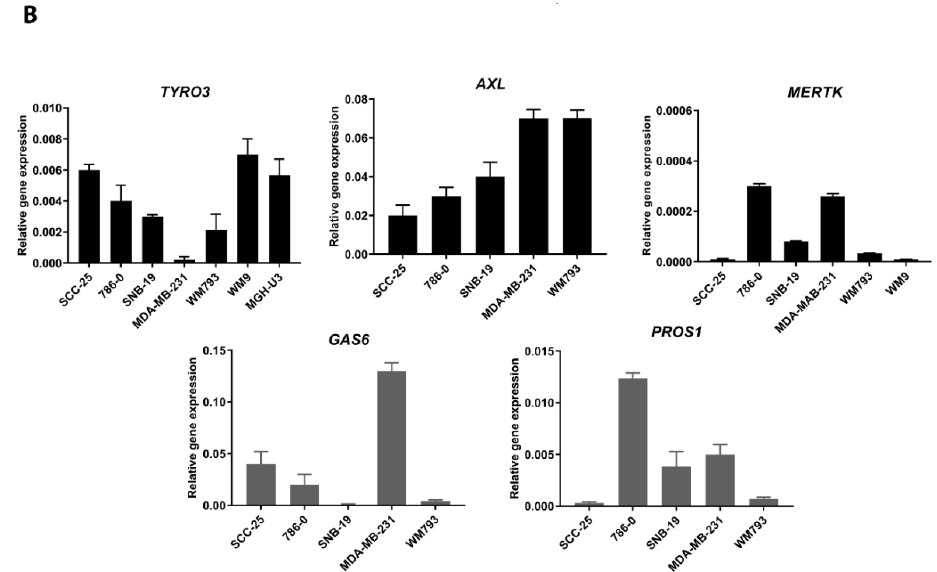
Figure 1. Expression of TAM RTKs and their ligands in a panel of human cancer cell lines (details in Supplementary Table S1). ( A ) Representative Western blot image from analysis of TAM receptors in protein extracts from various cultured human cancer cell lines, with accompanying graphs of protein quantification by densitometry. Bars are mean ± SEM protein expression normalized against β -actin as loading control protein (n = 3–6 separate experiments). ( B ) Quantitative RT-PCR analysis of mRNA expression of the genes for Axl, MerTK, Tyro3, Gas6 and ProS1 in extracts from five human cancer cell lines. Bars are mean ± SEM relative gene expression normalized against housekeeping gene GAPDH (n = three separate experiments).